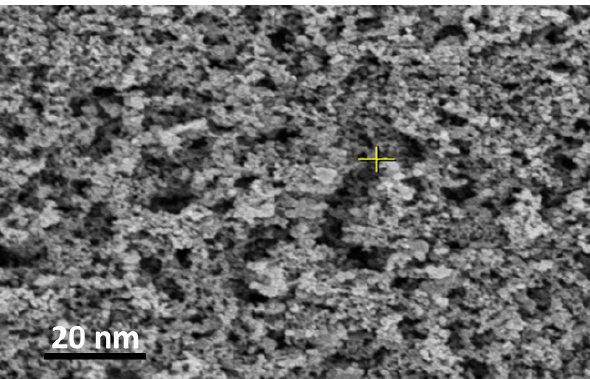
Figure 1. SEM image of electrochemically deposited Pd